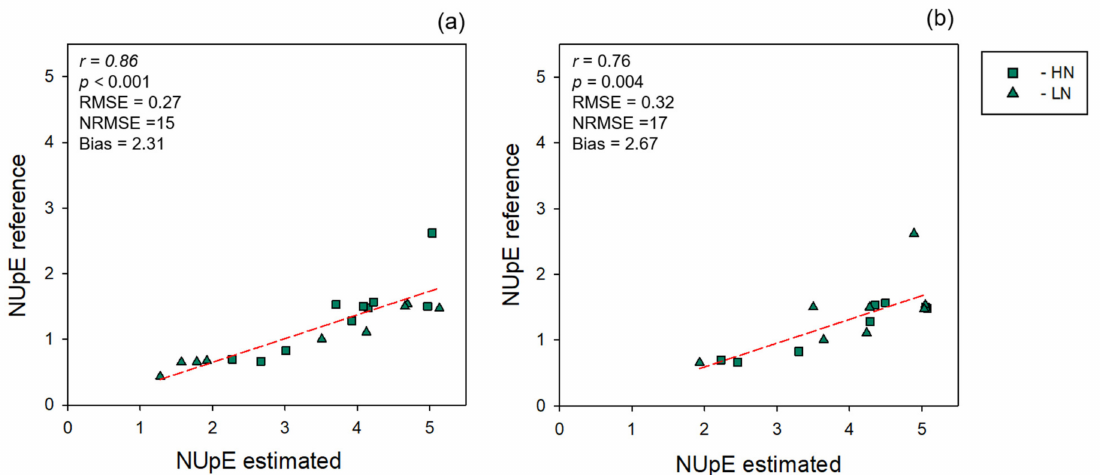
Figure 7. Relationships between nitrogen uptakes (NUpEs) calculated using either reference or estimated nitrogen values. ( a ) Leaf-level measurements, ( b ) canopy-level measurements. R 2 : model goodness of fit; RMSE: root-mean-square error; NRMSE: normalized root-mean-square error. NUpE reference: standard NUpE measurement. NUpE estimated: NUpE calculated using nitrogen predicted values as the input. Dashed line: 1:1